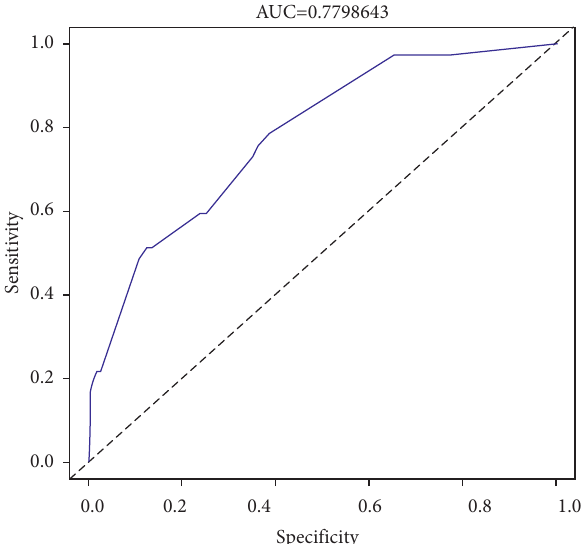
Figure 9: ROC curves for validating the discrimination of the nomogram prediction